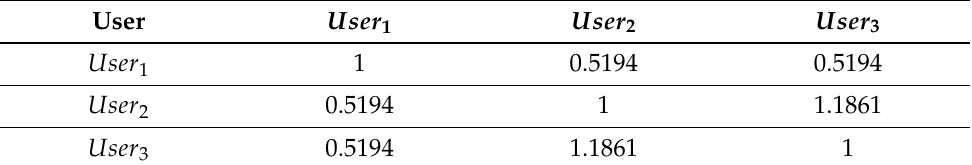
Table 10. User’s correlated value on items’ categorical attributes.